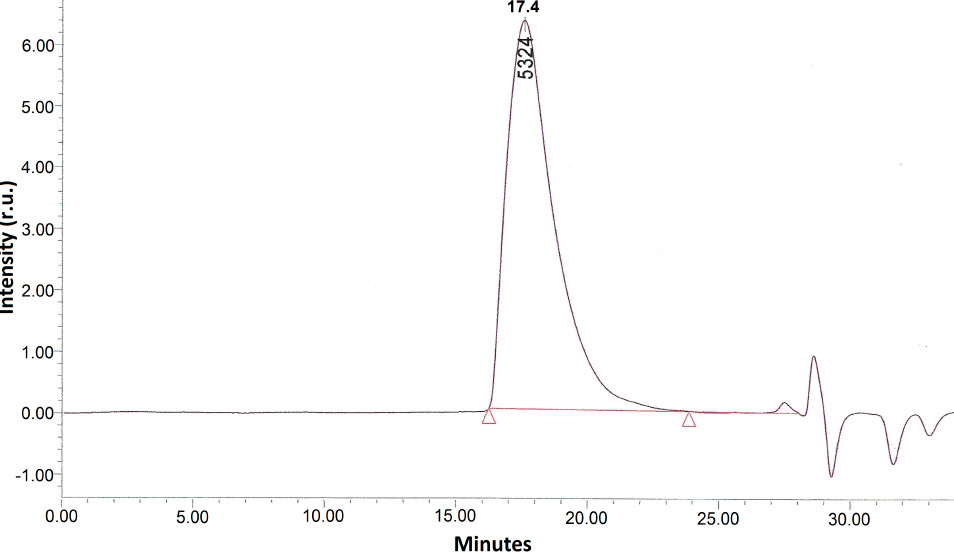
Figure 8. SEC elution profile of the reaction mixture obtained at the second stage, after its purification by reprecipitation. The red line and triangles indicate the signal boundaries of the main reaction product.